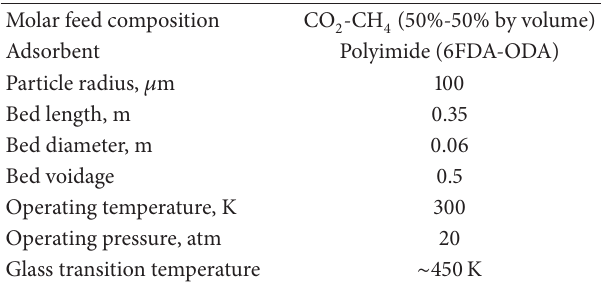
Figure 1: Schematic of the PSA column model with feed inlet and outlet. Table 1: Parameters used in separation of binary gas